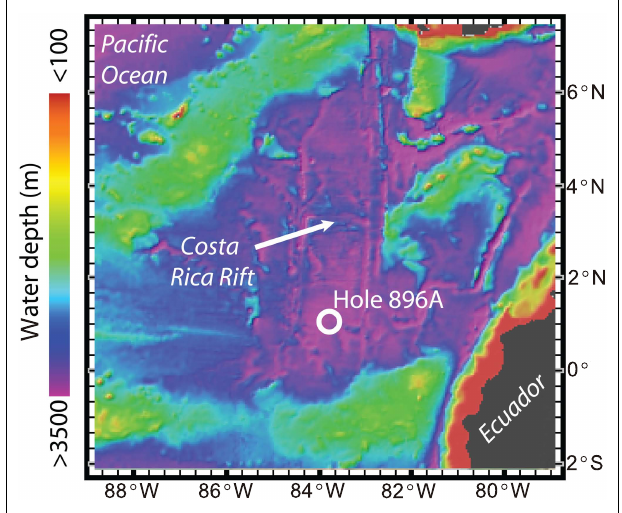
FIGURE 1 | Map of the Ocean Drilling Program Hole 896A study site in the Pacific Ocean in relation to the Costa Rica Rift. Color gradient scale provided for water depth in meters. Maps were created using the GeoMapApp software (www.geomapapp.org; Ryan etal.,